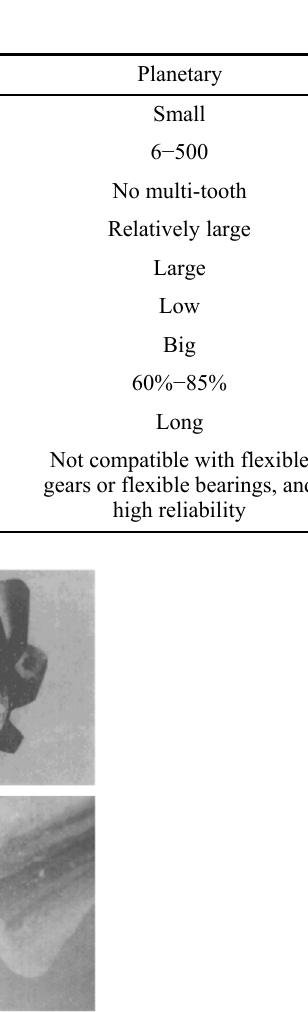
Fig. 8 Various kinds of gear teeth wear [72]: (a) moderate wear, (b) polishing, (c) abrasive wear, and (d) interference